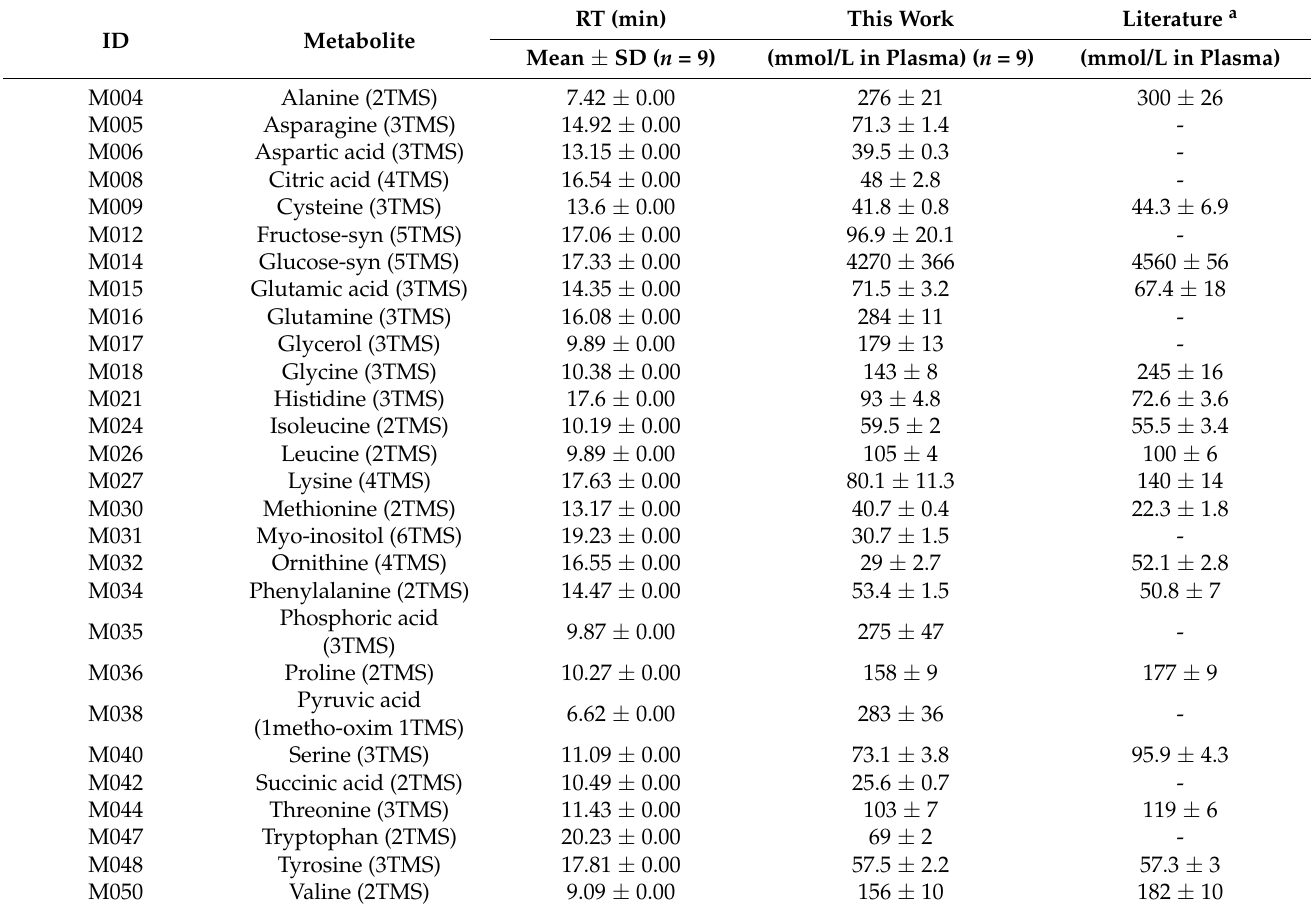
Table 3. Comparison of quantitative values of metabolites detected from